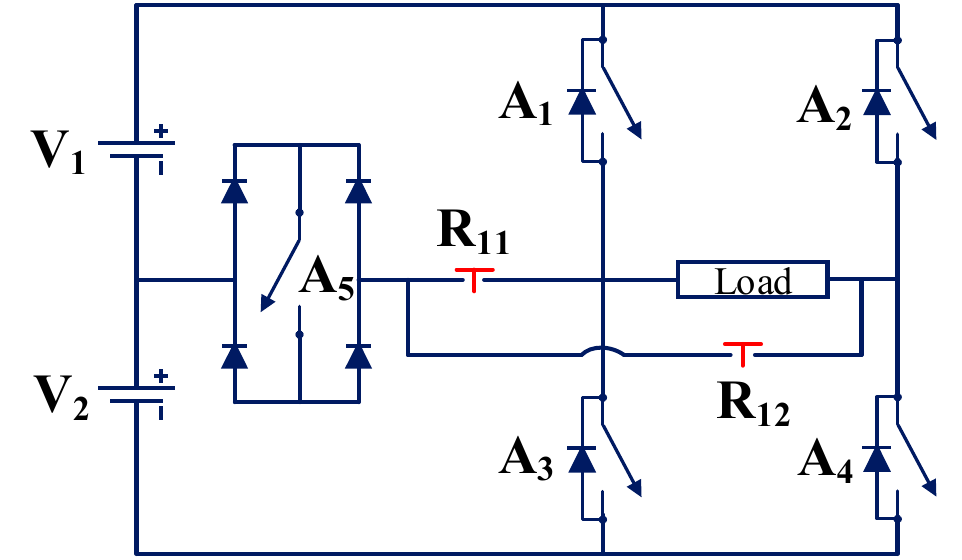
Figure 41. Single-phase five-level FT MLI (TP44) [76].